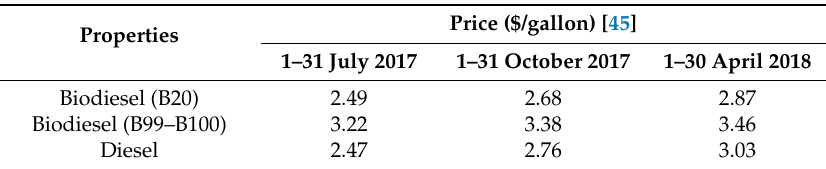
Table 5. The USA average fuel